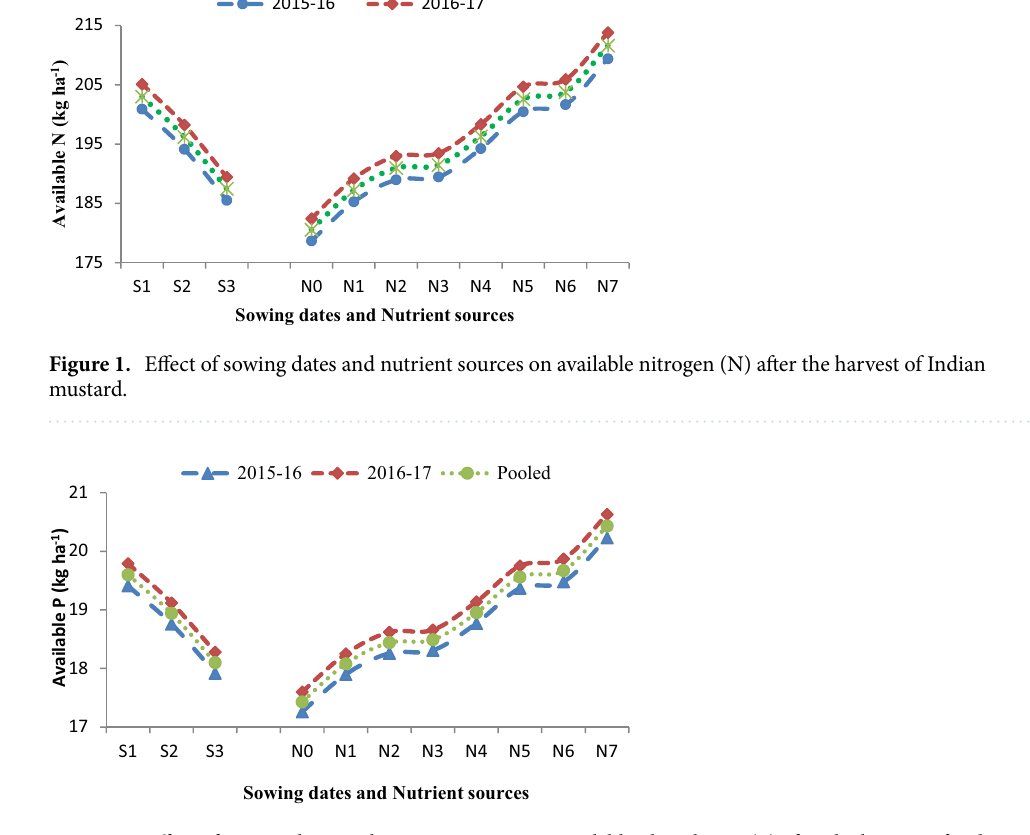
Figure 2. Effect of sowing dates and nutrient sources on available phosphorus (P) after the harvest of Indian